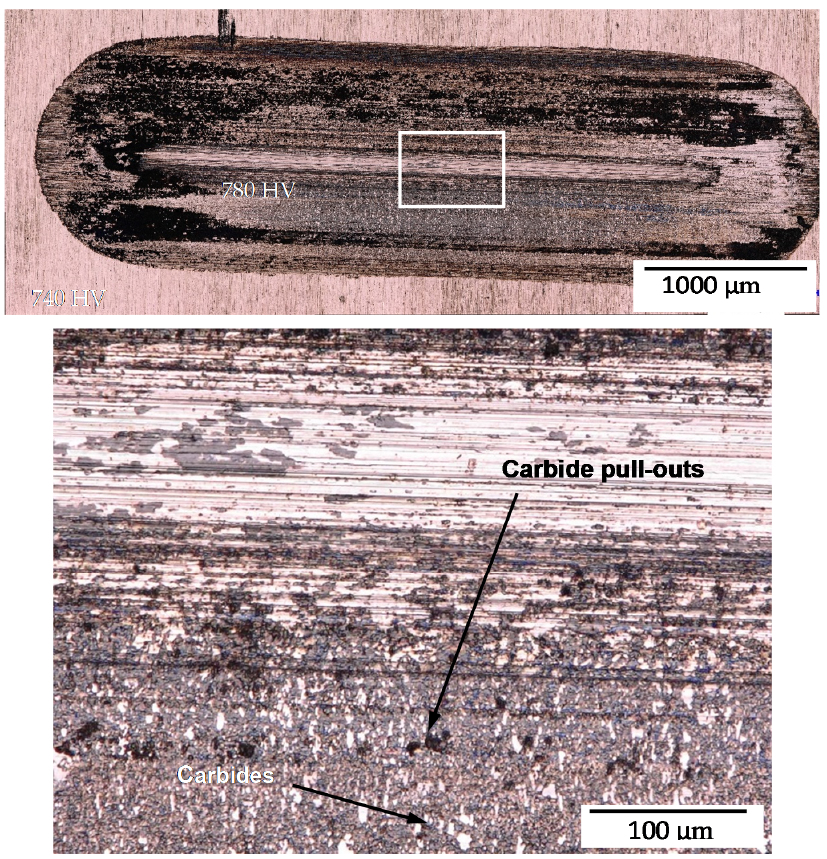
Figure 5. Abrasive wear test scar of AISI D2 tool